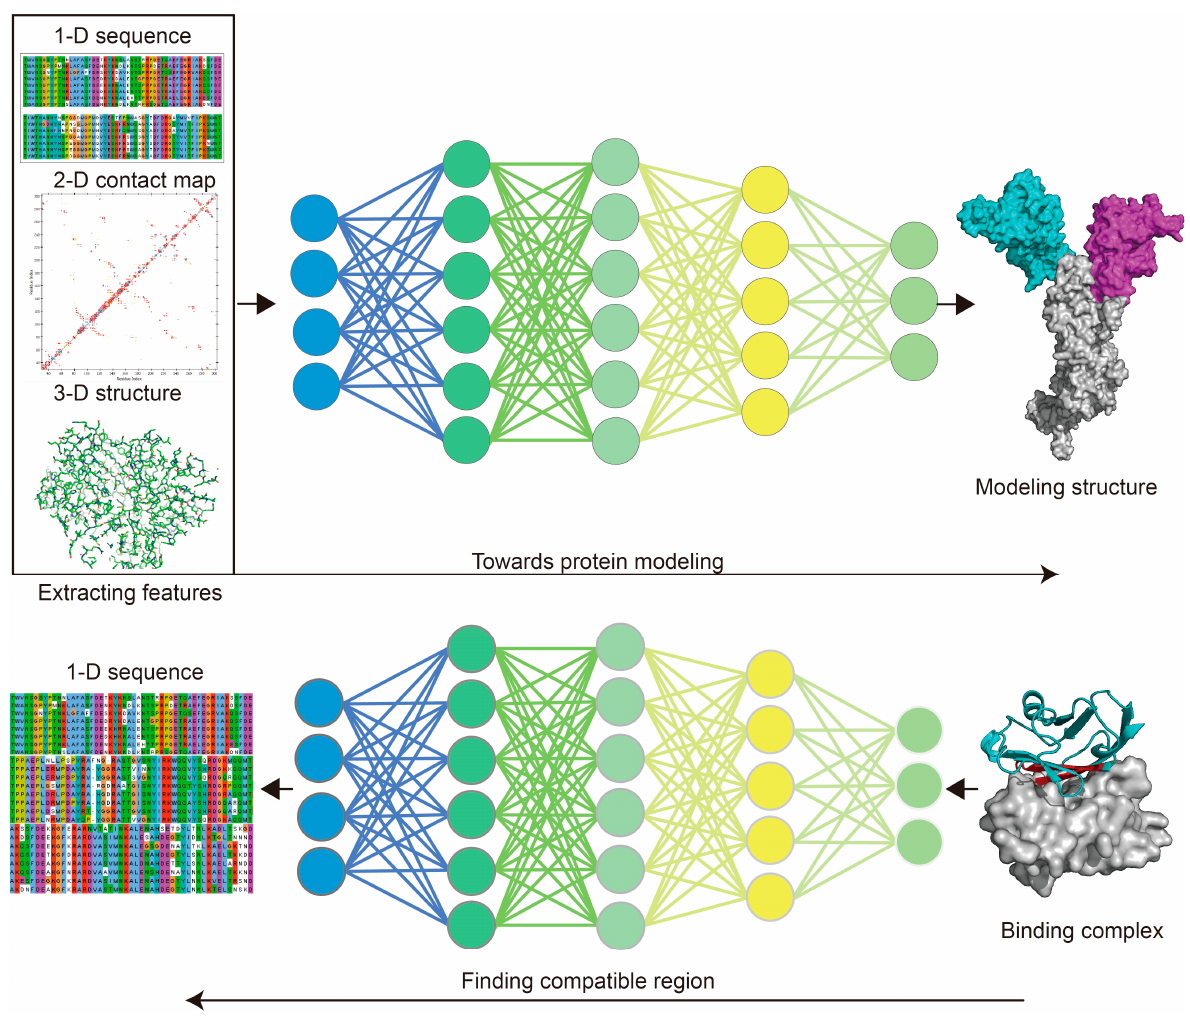
Figure 3. Deep learning used for structural modeling and design. For protein modeling, deep learning (DL) is used to learn sequence information (or MSA features) from the 1-dimensional sequences, residue–residue interaction information from the 2-dimensional contact map, or 3-dimensional structural information based on input structures, through aligning with the target structure (DL labels) to train the model. Protein de novo design takes advantage of protein modeling models by finding the compatible structure (and sequences) of the target block within a given protein to design novel proteins. Protein sequence alignment generated using Jalview. Protein 2-dimensional contact map generated using Discovery Studio 2019. Protein structure generated using PyMol.